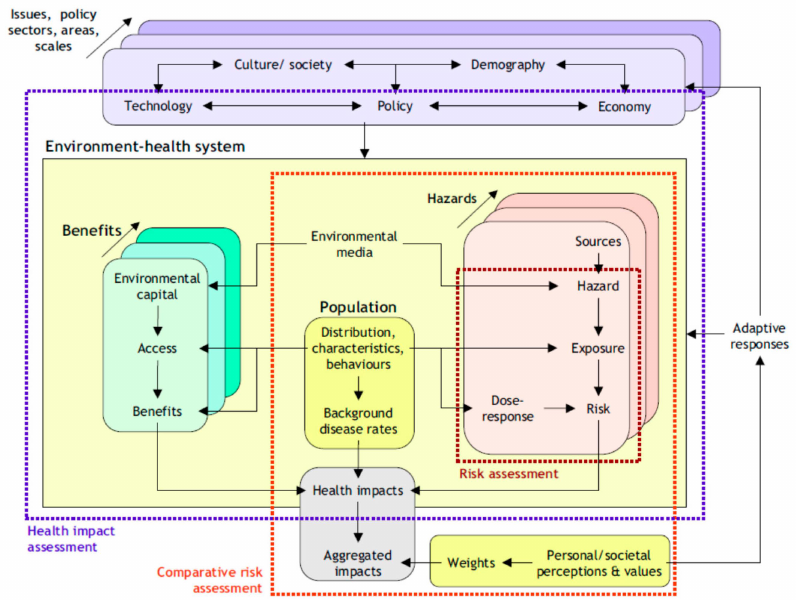
Figure 2. Structural framework of Integrated Environmental Health Impact Assessment (IEHIA) in relation to other forms of risk and impact assessment (from